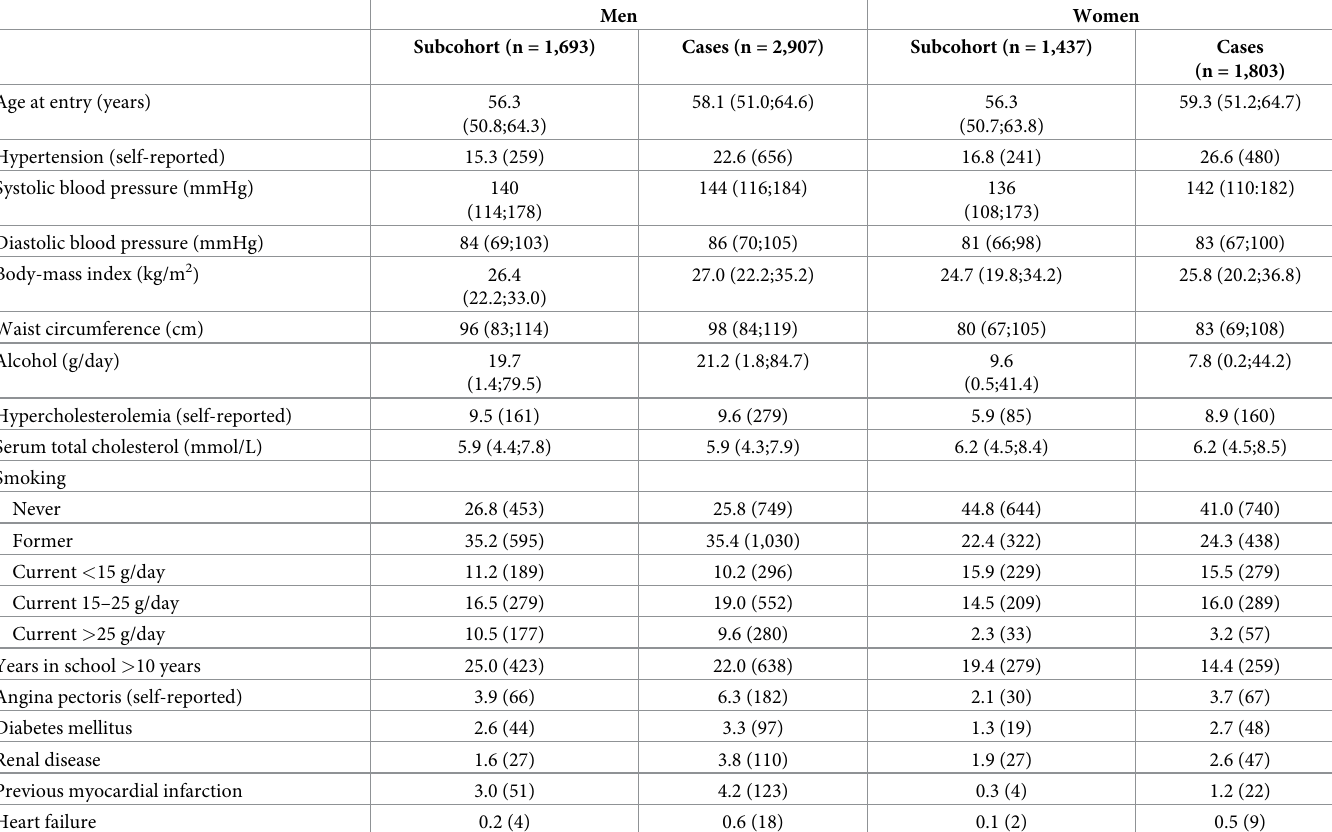
Table 1. Baseline characteristics of participants and